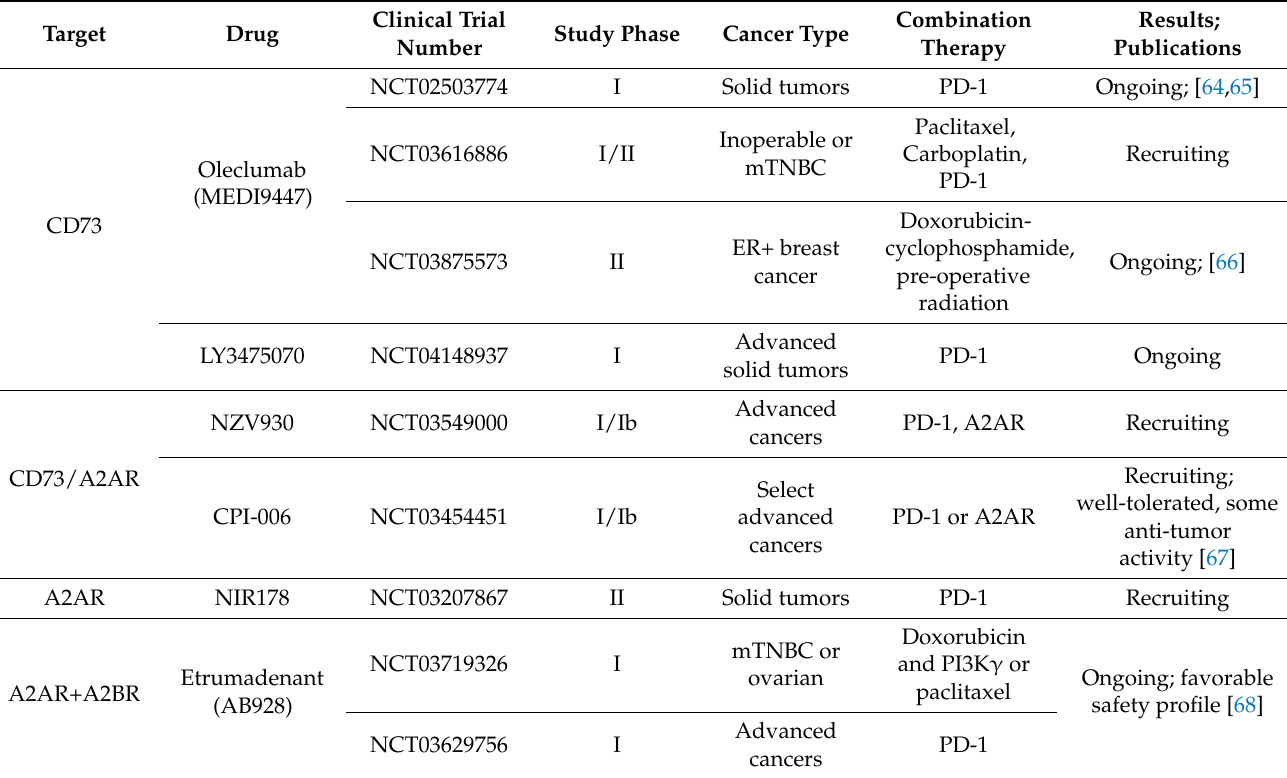
Table 2. Summary of clinical trials targeting the adenosine pathway in breast